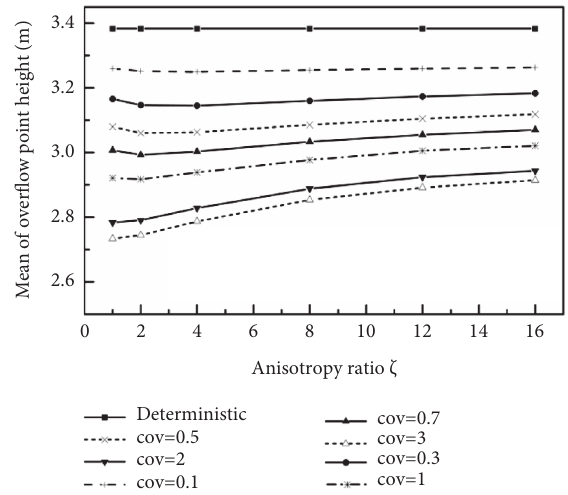
Figure 6: Variation of overflow point height with hydraulic conductivity for different values of COV.